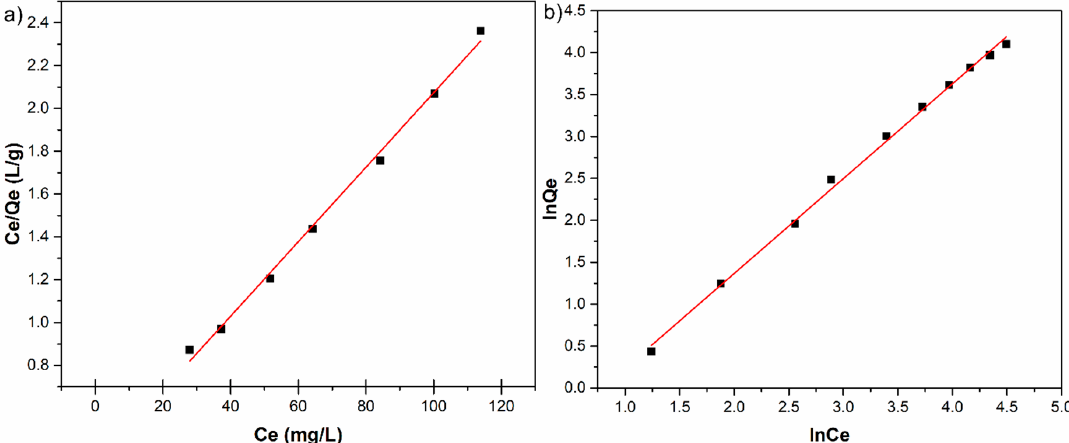
Figure 8. Langmuir ( a ); and Freundlich ( b ) linearized fits for the adsorption of zinc ions on HAp. Table 2. Isotherms parameters for zinc adsorption onto HAp.